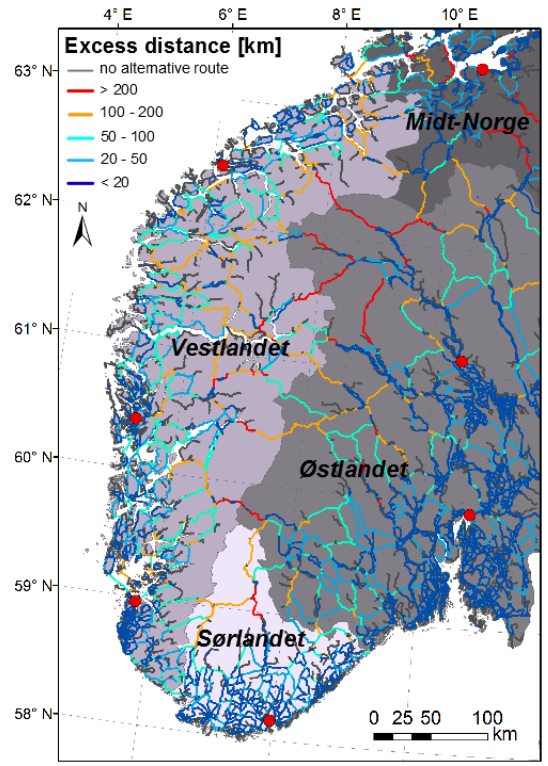
Figure 5. Excess distances resulting from potential road